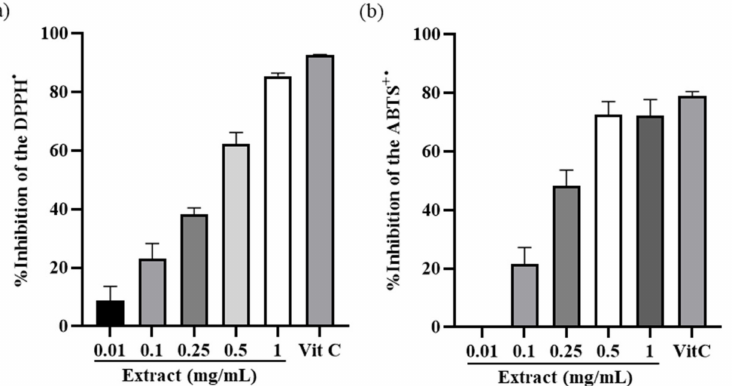
Figure 1. ( a ) DPPH and ( b ) ABTS radical scavenging activity of I. indigotica leaf extract at different concentrations. Vitamin C (ascorbic acid) was used as the positive control. Data were obtained through three independent replicates.